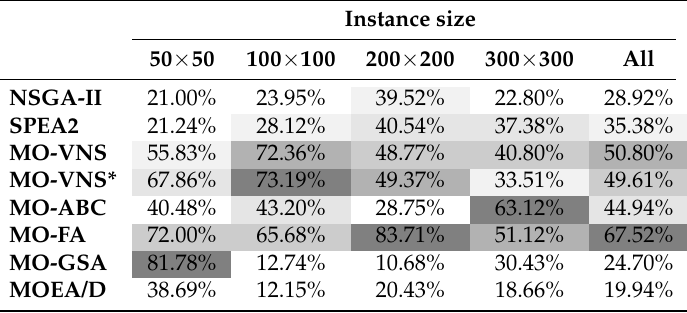
Table 8. Average set coverage for a metaheuristic compared to any other solving the three-objective